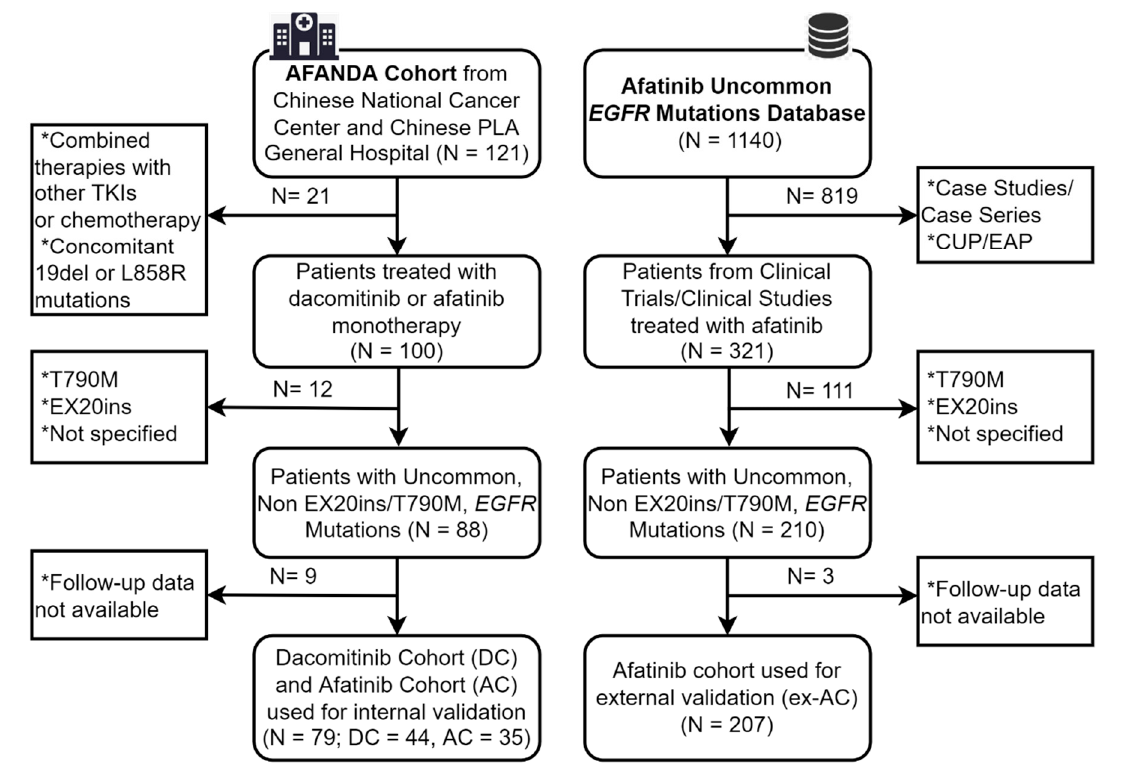
Figure 1. Flow chart of patient selection. EGFR , epidermal growth factor receptor; TKI, tyrosine kinase inhibitor; EX20ins, exon 20 insertion mutations; DC, dacomitinib cohort; AC, afatinib cohort; ex-AC, external afatinib cohort; CUP/EAP, compassionate-use program/expanded-access program.